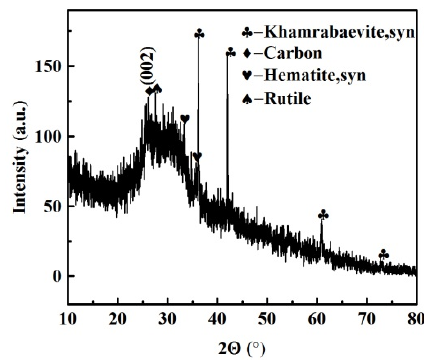
Figure 1. XRD pattern of FEBFS samples.